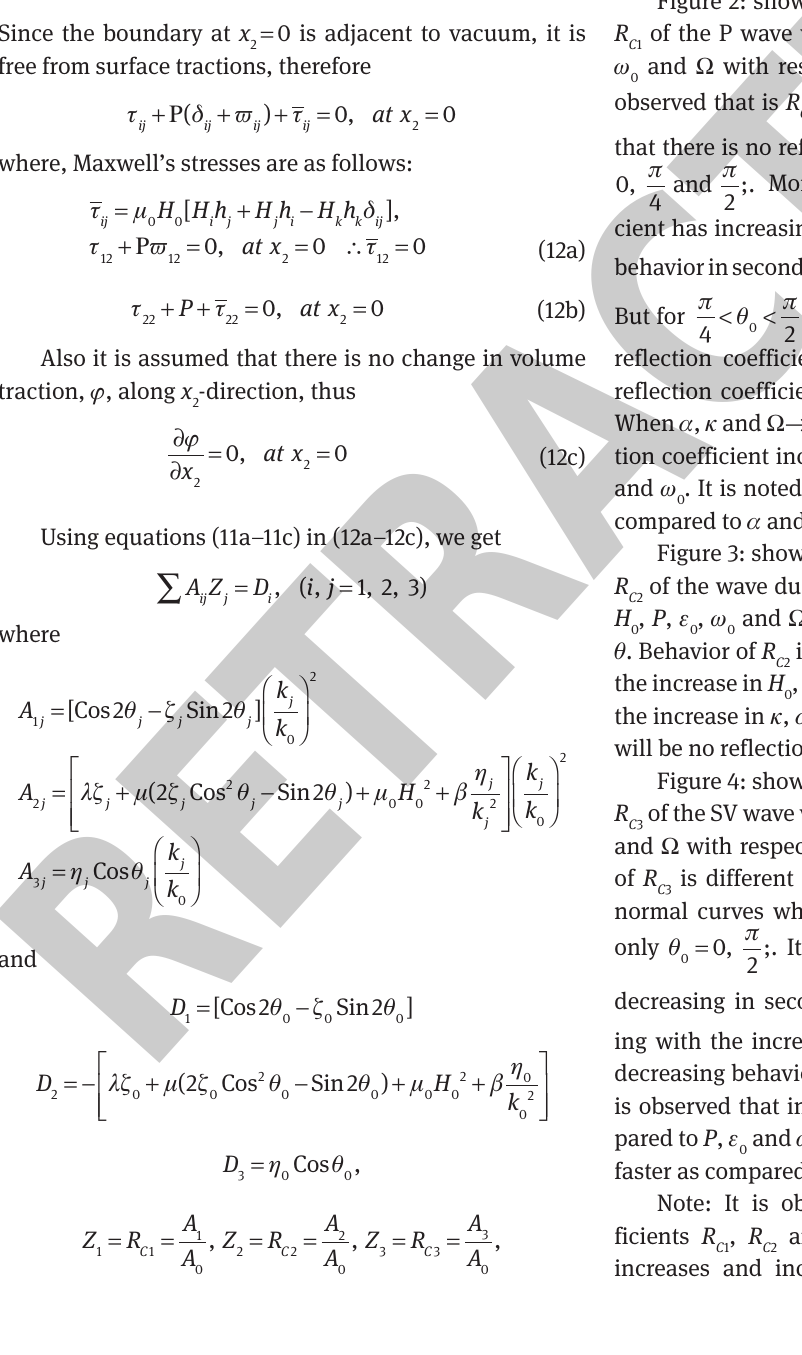
R of the P wave with the variation of κ , ω , α , H C 1 ω and Ω with respect to the angle of incidence θ . It is 0